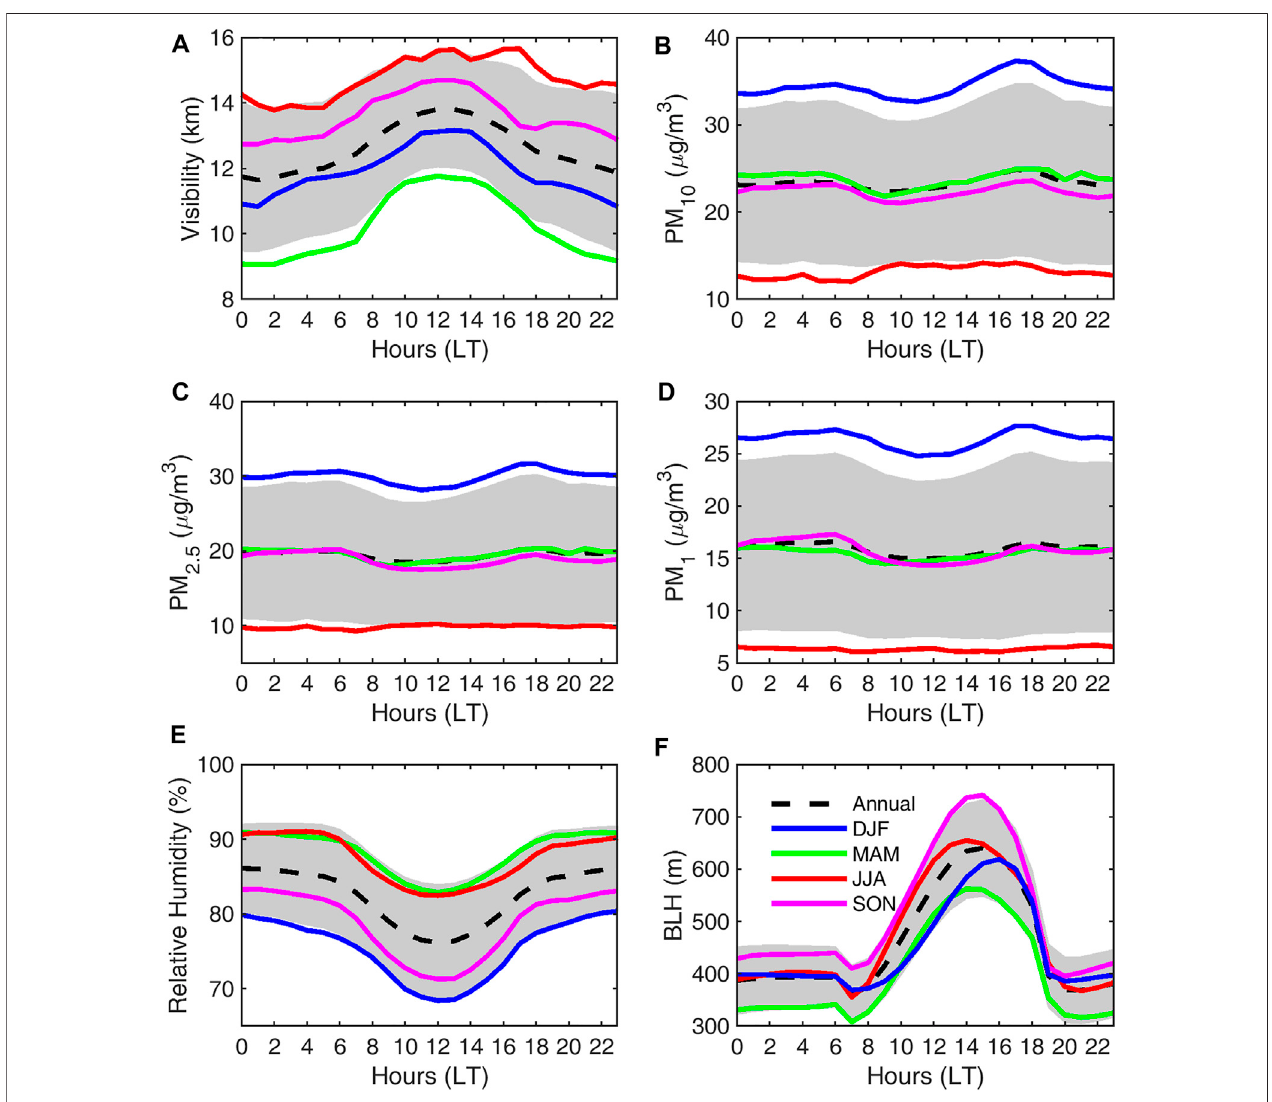
FIGURE 4 | The diurnal variations in multi-year averaged visibility (A) , PM 10 (B) , PM 2.5 (C) , PM 1 (D) , RH (E) , and BLH (F) for four seasons at Xichong.